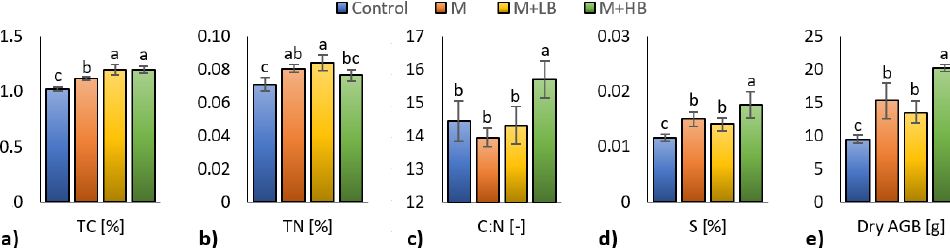
Figure 1. Mean values of chemical properties of soil and above ground biomass production. ( a ) TC = total soil carbon, ( b ) TN = total soil nitrogen, ( c ) C:N = total soil carbon/nitrogen ratio, ( d ) S = total soil sulphur, ( e ) Dry AGB = dry plant aboveground biomass. Average values of independent repli- cates ( n = 3), error bars = standard deviation; the different letters express the statistical differences at the significance level p ≤ 0.05.